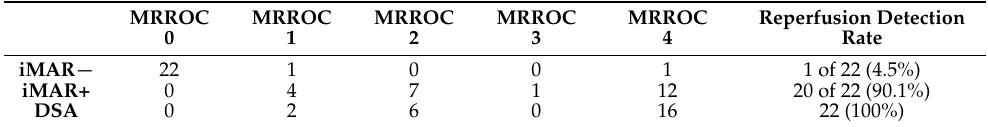
Table 5. Aneurysm occlusion grading in IAs treated via coiling.